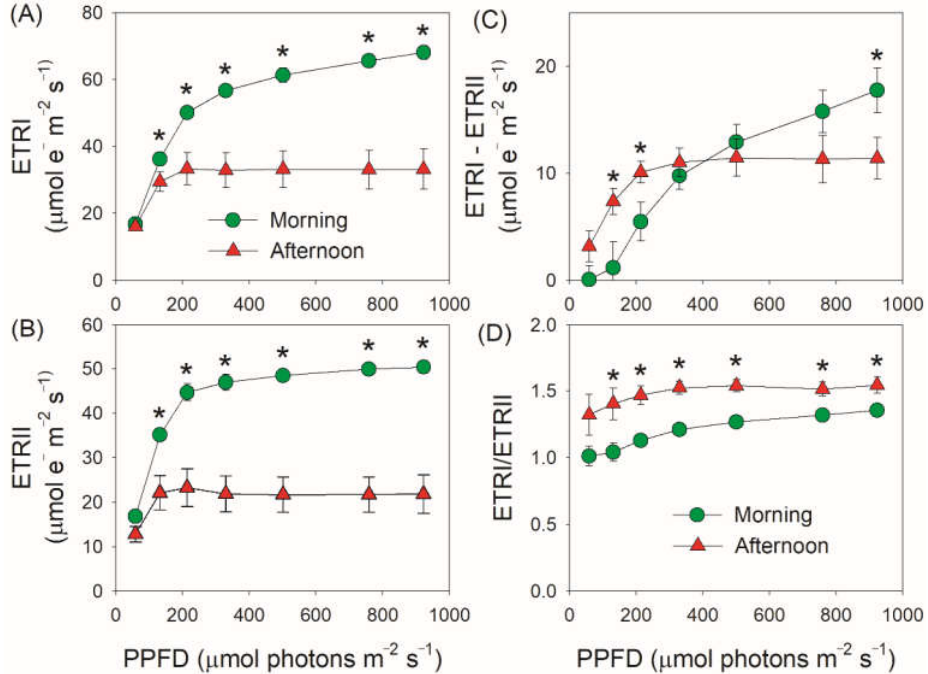
Figure 3. Light intensity dependence of electron transport rates for leaves of Vanilla planifolia mea- sured in the morning and in the afternoon. ETRI ( A ), electron transport rate through PSI; ETRII ( B ), electron transport rate through PSII; ETRI–ETRII ( C ), estimated rate of cyclic electron flow; ETRI/ETRII ( D ), an indicator reflecting the contribution of cyclic electron flow to total photosynthetic electron flow. Data are means ± SE ( n = 5). Asterisk indicates a significant difference between morning and afternoon.